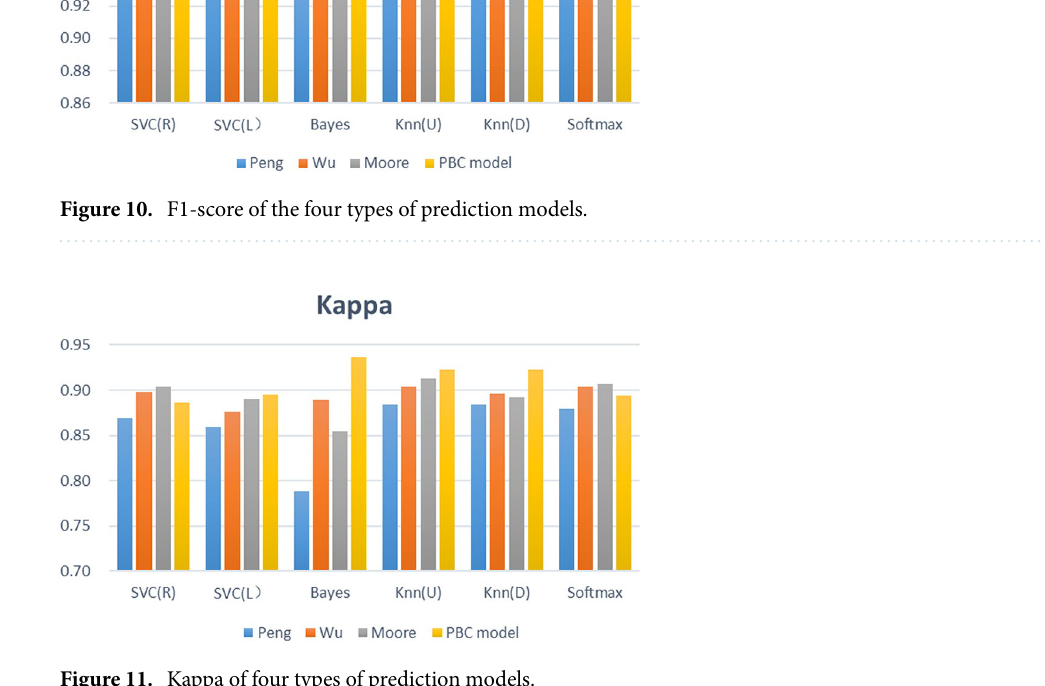
Figure 11. Kappa of four types of prediction